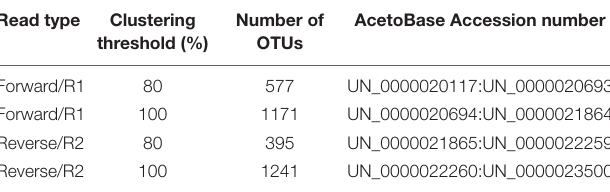
TABLE 3 | Details of the dataset submitted to AcetoBase, with number of OTUs and their AcetoBase accession number